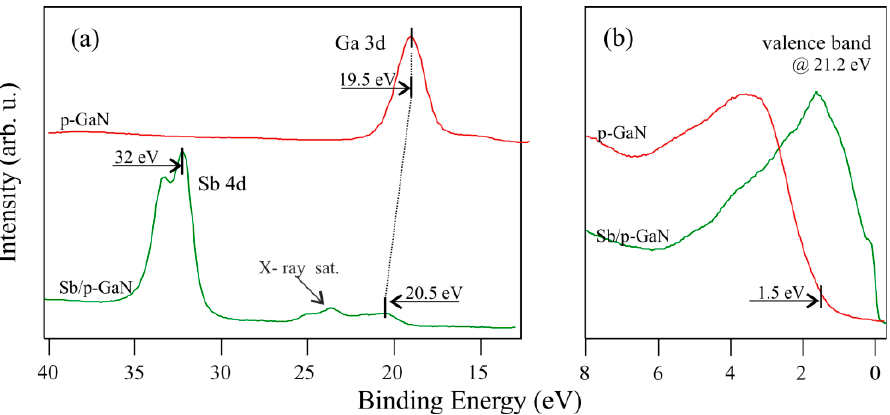
Figure 34. XPS spectra of ( a ) Ga ‐ 3d, Sb ‐ 3d, and ( b ) UPS spectra of the valence band for bare and Sb film ‐ covered GaN(0001). Mean thickness of the film is 5 nm. Data previously published in [57].